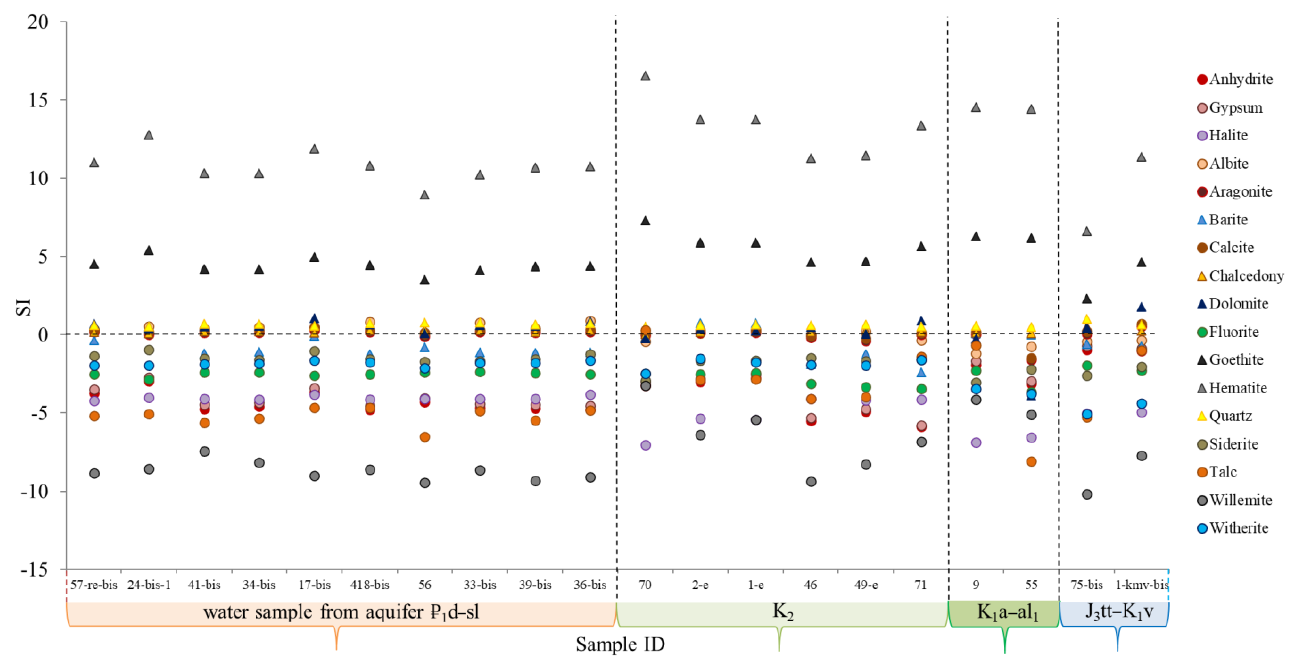
Figure 7. Gibbs diagram of natural mineral waters samples: ( a ) anion ratio (Cl − /(Cl − +HCO 3 − ); ( b ) cation ratio (Na + +K + )/(Na + +K + +Ca 2+ ).